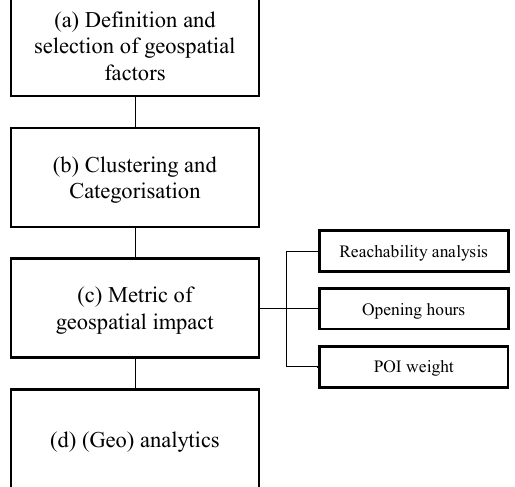
Figure 1: Process to identify geospatial key factors